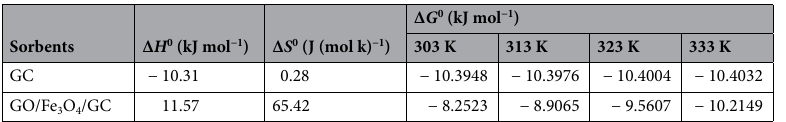
Table 4. Thermodynamic parameters of U(VI) adsorption on GC and GO/Fe 3 O 4 /GC.